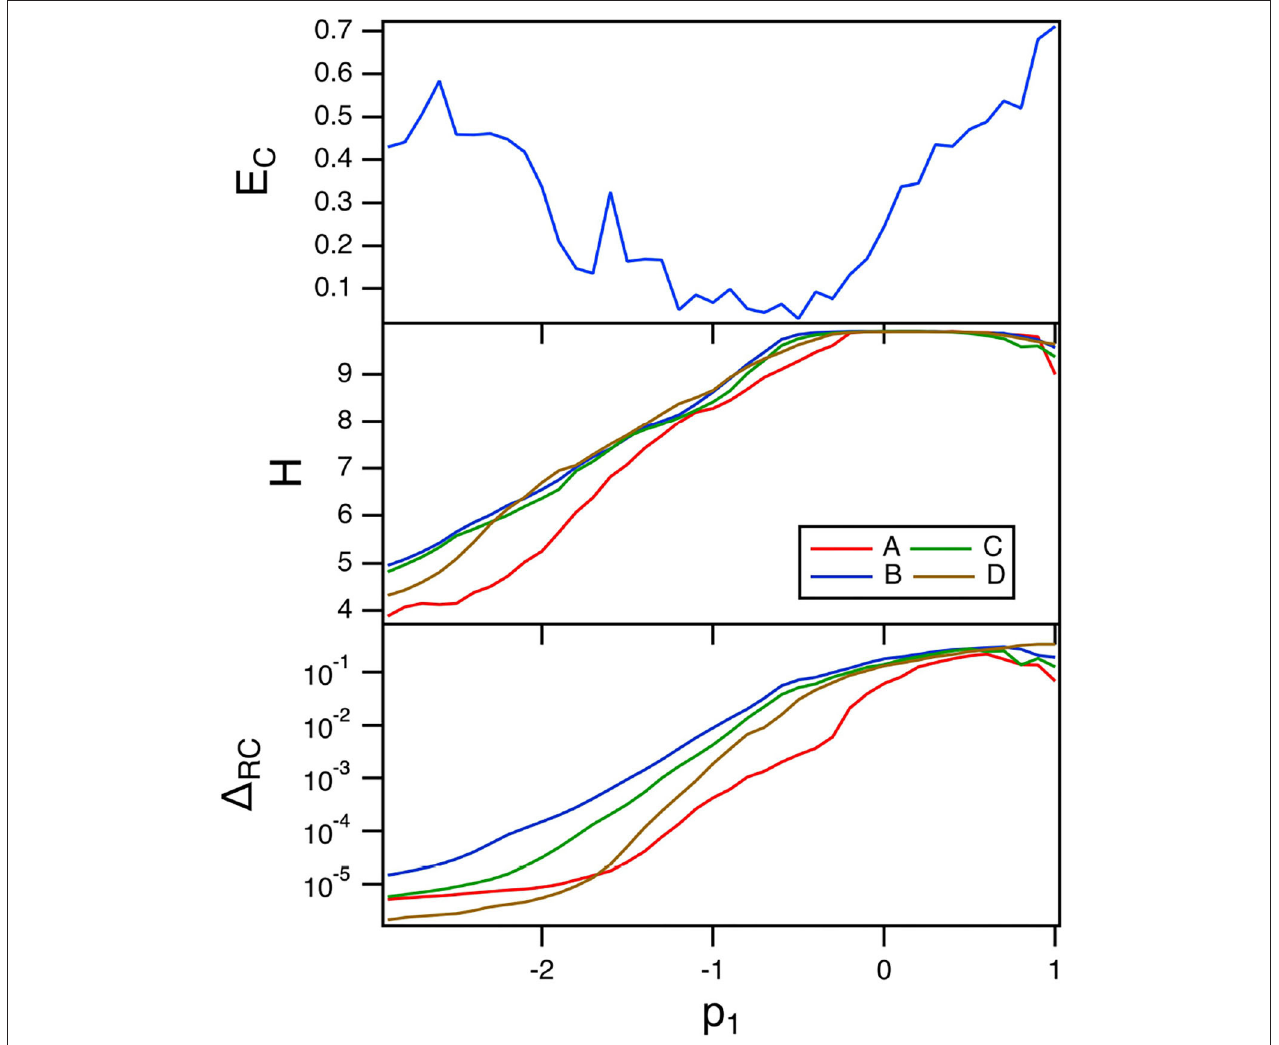
FIGURE 8 | The top plot shows the fraction of errors E C in identifying which of the four Sprott systems was present, as a function of the linear parameter p 1 for the polynomial ODE reservoir computer. The middle plot shows the entropies for the four Sprott systems over the same parameter range. The bottom plot shows the training error 1 RC . For this plot, α = 0.3 and the spectral radius σ = 0.8.